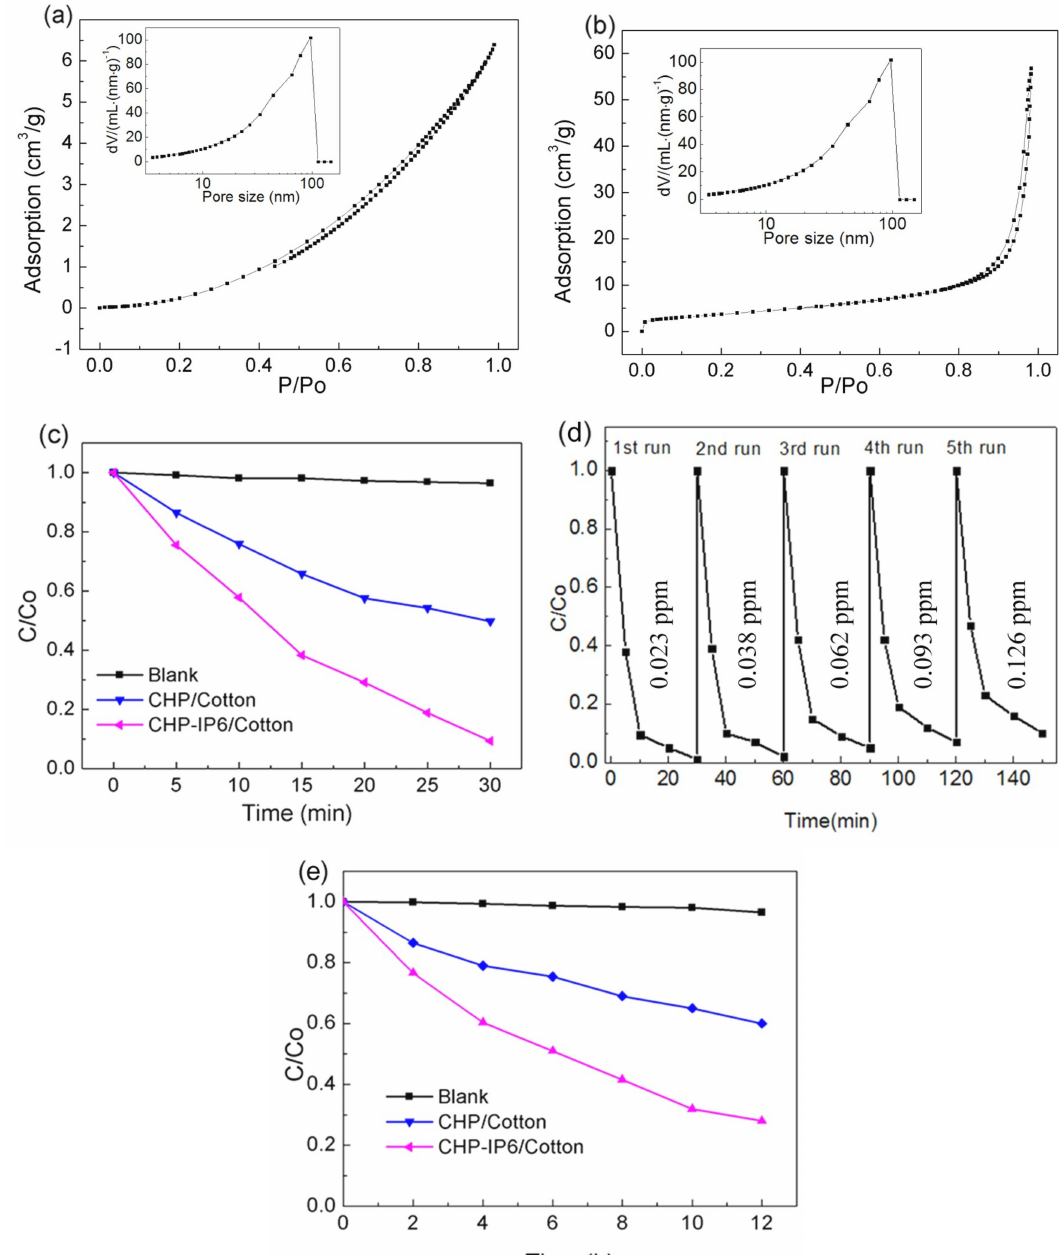
Figure 7. Nitrogen adsorption-desorption isotherms and pore size distributions of ( a ) CHP and ( b ) CHP-IP6; ( c , e ) Photocatalytic degradation of MB under VIS–NIR and NIR irradiation, respectively; and ( d ) cycling tests under VIS–NIR irradiation and concentrations of Cu(II) ions after each test